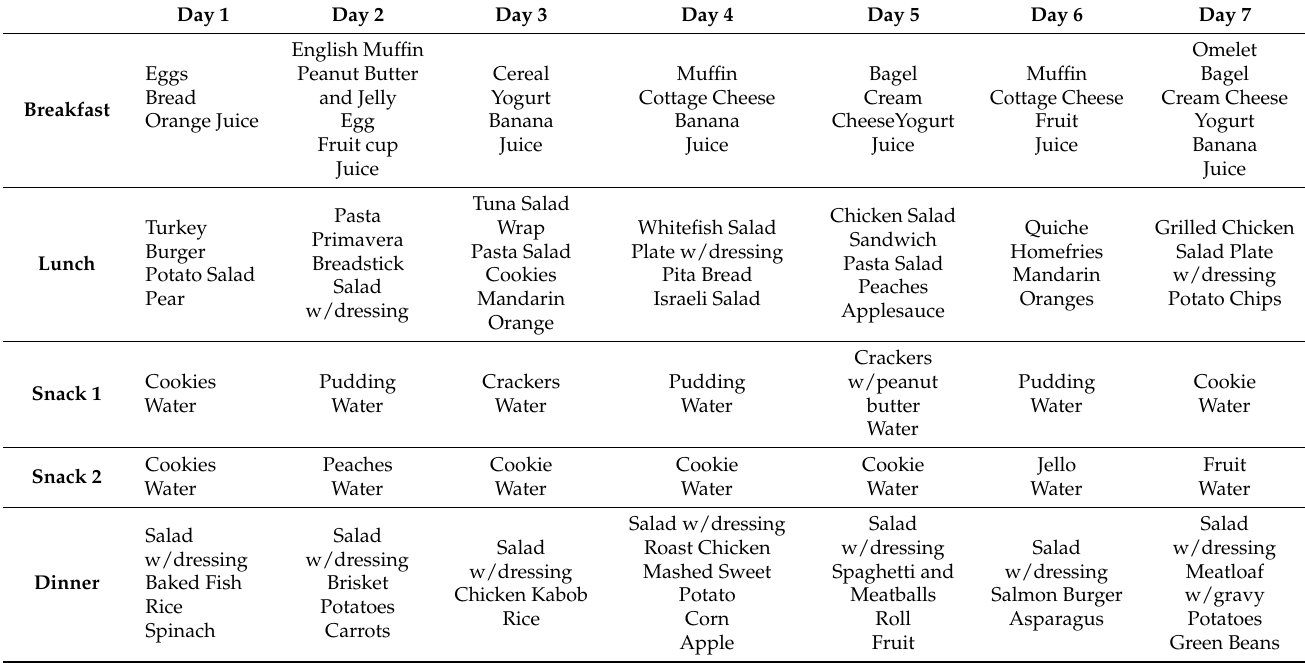
Table 1. The 7-day meal plan for the low and typical sodium groups in the SOTRUE study.